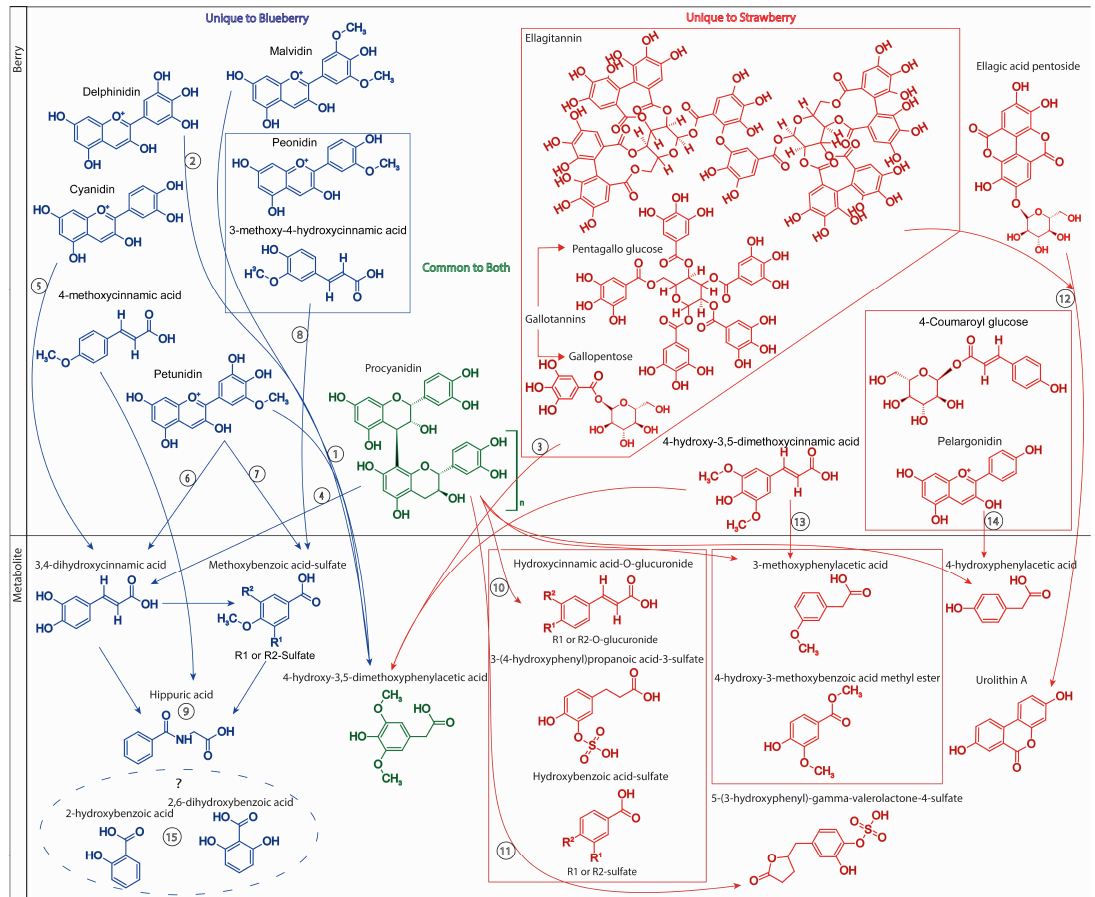
Figure 7. Proposed catabolism of precursor compounds to yield metabolites observed in the blueberry and strawberry interventions. The pathways of metabolites are speculative, and based on the structure and reported metabolism for monomeric (poly)phenols, as the microbial catabolic pathways for gallotannins, ellagitannins, and procyanidins are presently not fully characterized in humans. Isotope-labelling studies are required to characterize these pathways. Predictions were made using data from human studies feeding (poly)phenol-rich foods [5,10,16,24,25,31,36,37] and literature from environmental microbiology